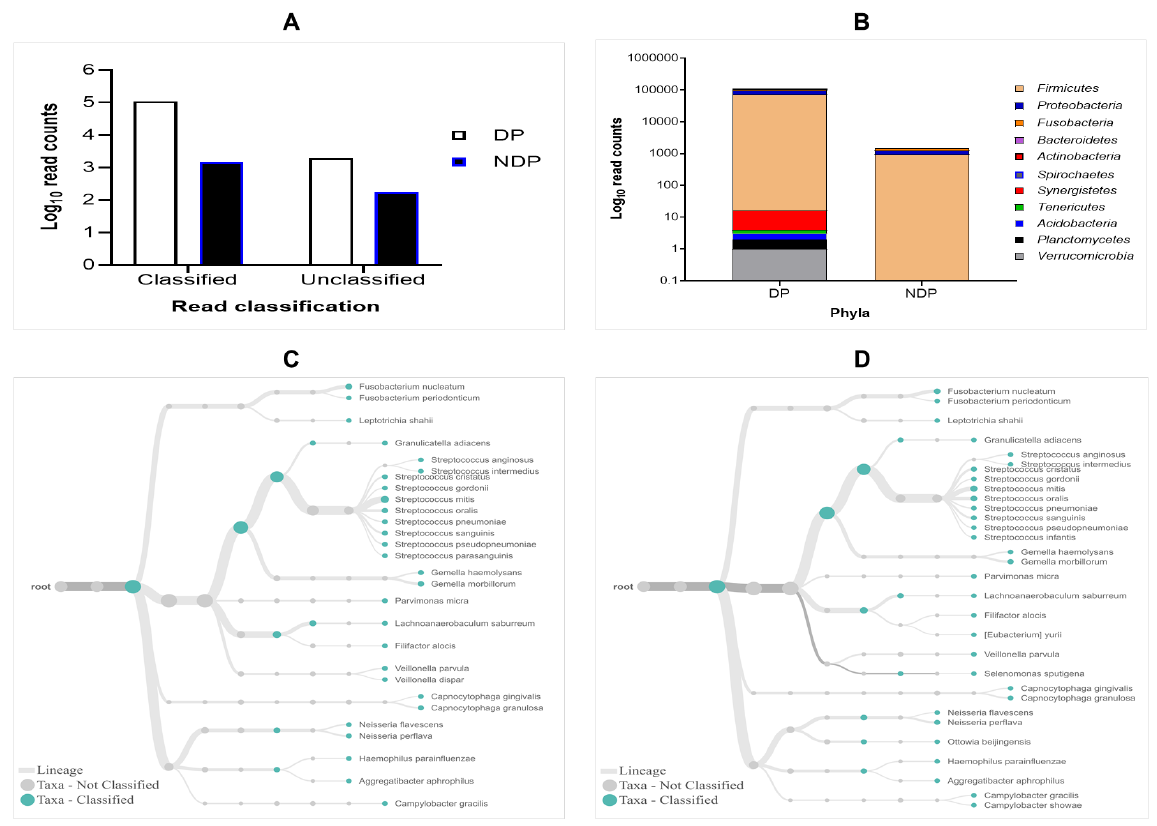
Figure 1. Read classification across pooled subgingival microbiota samples collected from diabetic (DP) and non-diabetic (NDP) patients. ( A ) Taxa-level; ( B ) phylum; ( C and D ) root taxa in DP ( C ) and NDP ( D ) groups.